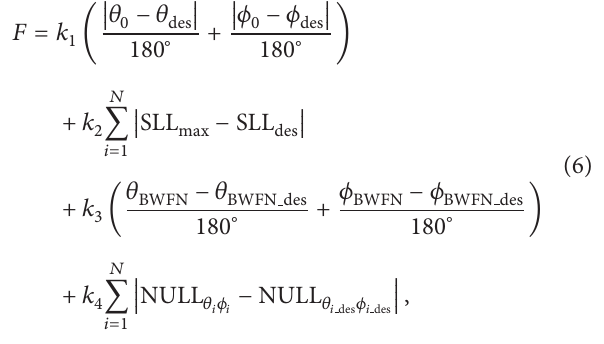
be found in literature [17–19]. In the chaotic beamforming algorithm, we used equations for Chua’s oscillators with parameters corresponding to the double-spiral chaotic attrac- tor